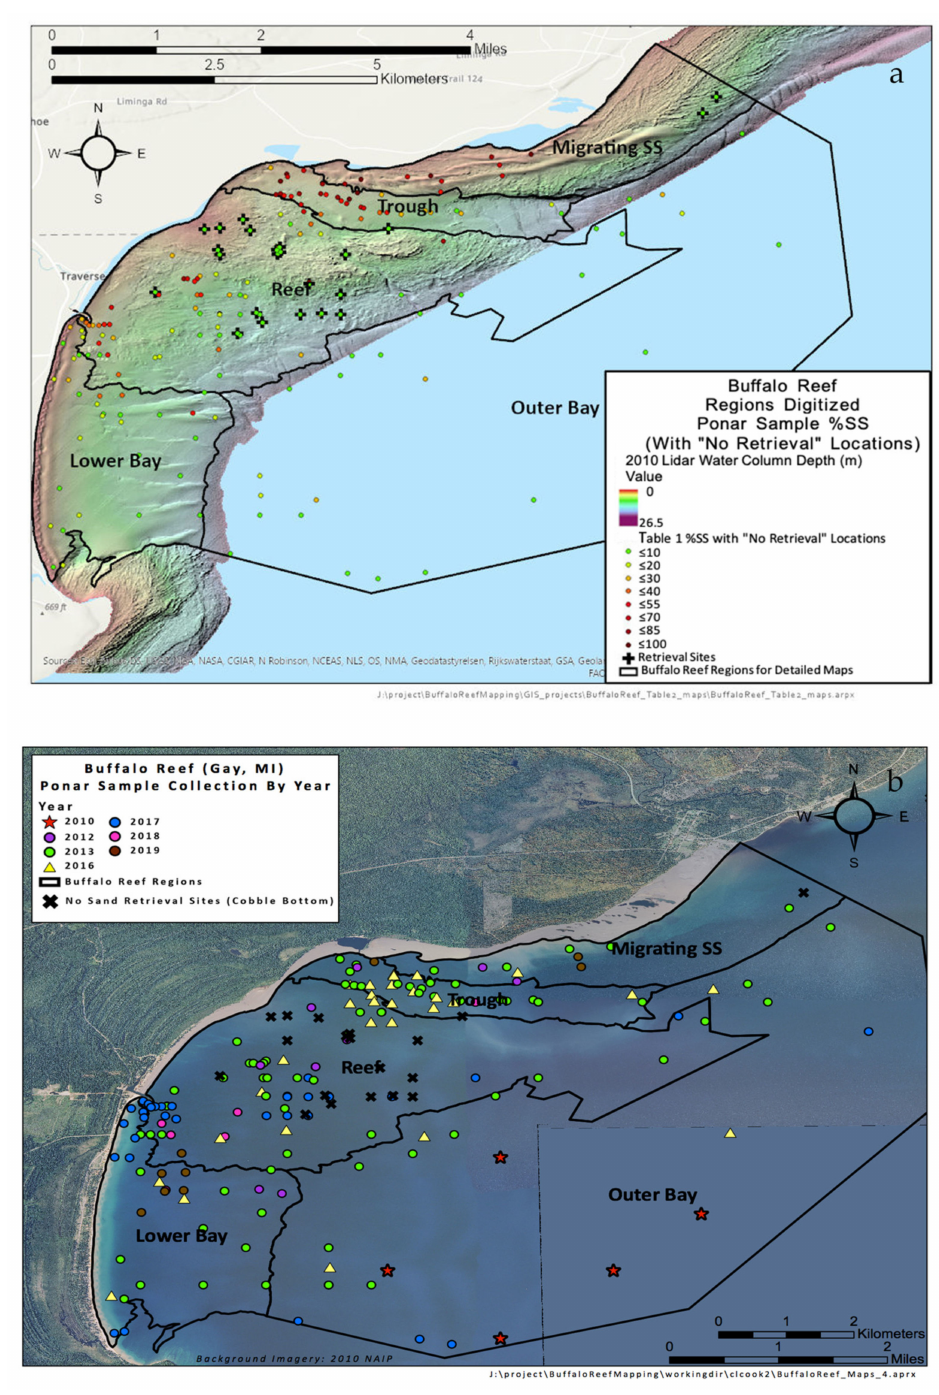
Figure 6. Geospatial sampling locations: ( a ) Ponar sites (2008–2019) in Grand (Big) Traverse Bay superimposed upon the 2016 LiDAR DEM. Note the substrate detail evident in LiDAR DEMs (here and Figure 3). Regions include: ‘underwater migrating stamp sand bars’, the ‘trough’, ‘Buffalo Reef’ (bedrock, cobble, and boulder beds), natural sand ‘Lower Bay’, and the deep-water ‘Outer Bay’. The black outlines of the five geospatial analysis regions are superimposed on the Grand (Big) Traverse Bay DEM. ( b ) Scattered Ponar sample collection sites color-coded by year (2010–2019, see legend in upper left). Major analysis regions are again indicated by black borders. Notice dominance of sampling in 2013 (green circles). “No retrieval” sites (green diamonds above; black below) are also shown, largely over bedrock or paved cobble